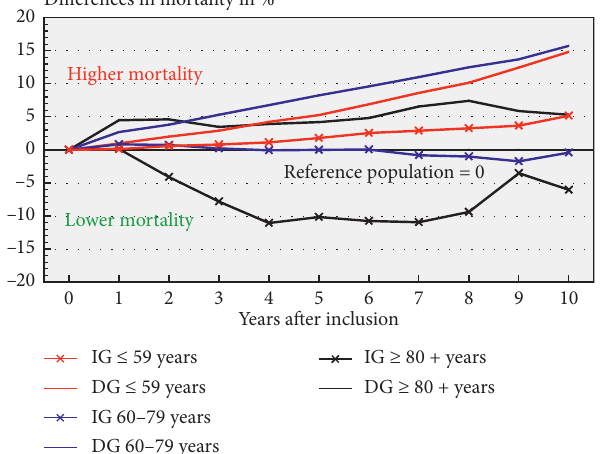
Figure 2: The difference in 10-year mortality between reference populations and patients treated with (IG, implant group) or without implants (DG, denture group) in different age groups over time. Difference in mortality compared to the corresponding reference population was significant for all groups ( p < 0 .